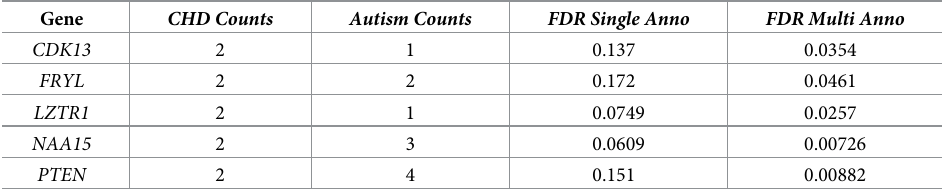
Table 2. Pleiotropic effect boosts power for M-DATA multi-trait